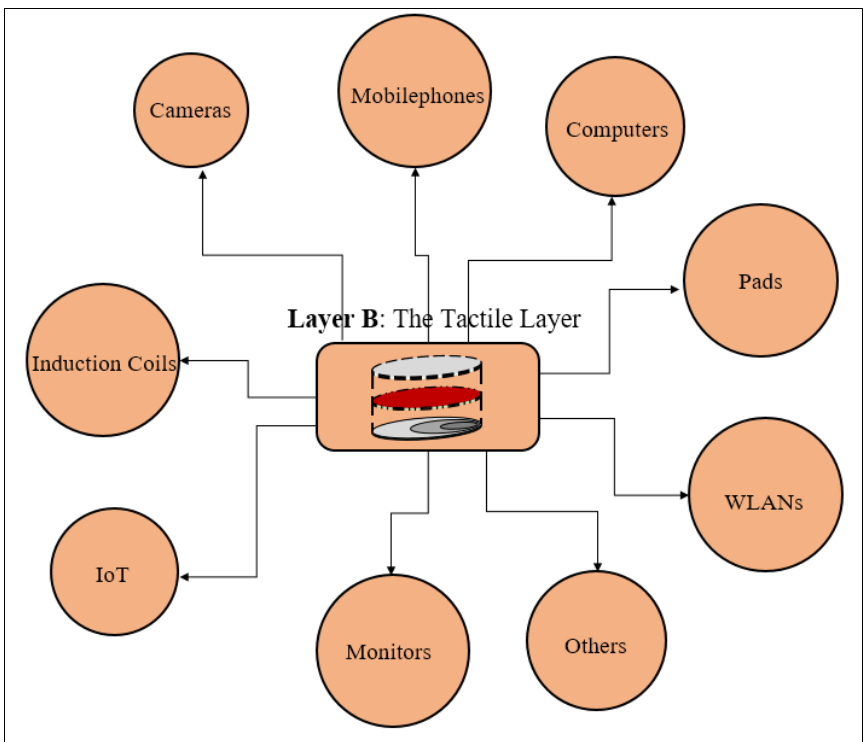
Figure 15. The main characters of Layer